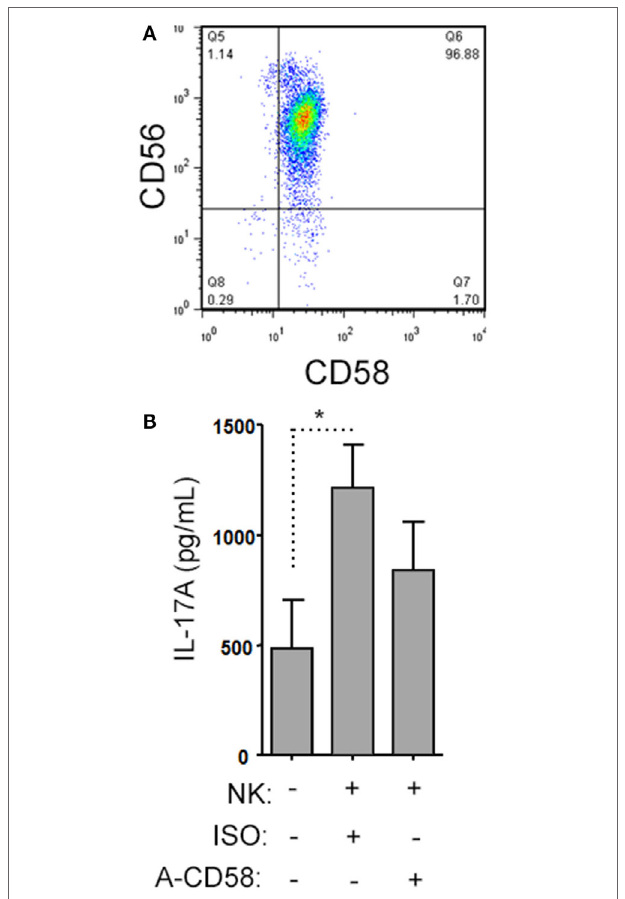
FigUre 9 | Natural killer (NK) cells support IL-17A expression by helper T (Th) cells by CD58 co-stimulation. A representative plot of CD58 expression by CD3 − CD56 + NK cells is shown from healthy subject peripheral blood mononuclear cell (PBMC) (a) . Memory CD4 + T cells from healthy subjects PBMC were activated with anti-CD3, anti-CD28, and Th17 polarizing factors with NK cells in the presence or absence of CD58 neutralizing or isotype control antibody for 4 days. The cytokine IL-17A was assessed by enzyme- linked immunosorbent assay from cell culture supernatants (B) . Graph indicates mean IL-17A concentration for N = 3